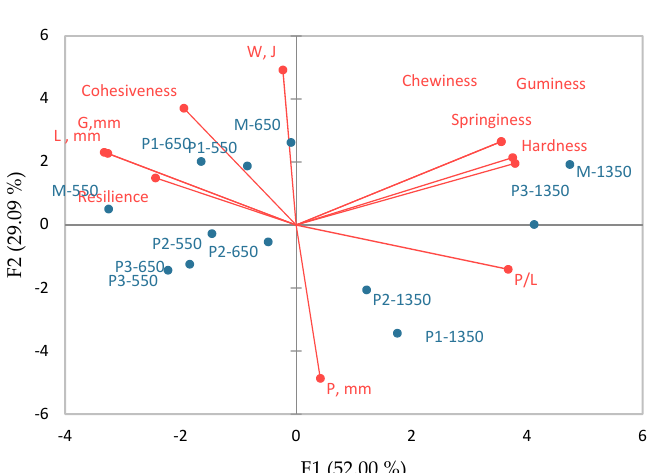
Figure 6. Analysis of the main components for the correlations between the bread samples and the rheological and textural characteristics.